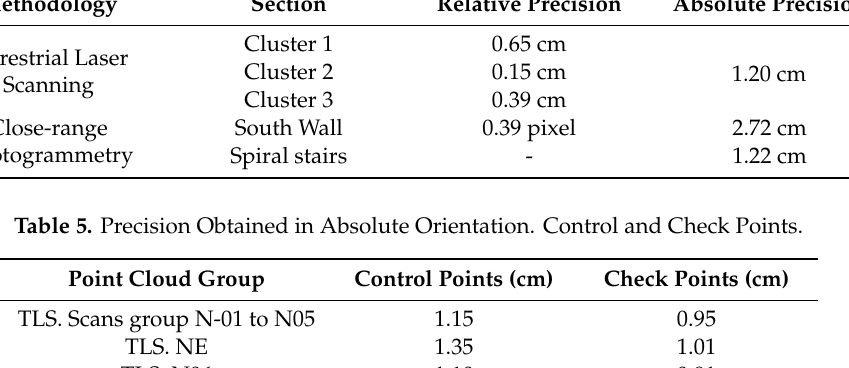
Table 5. Precision Obtained in Absolute Orientation. Control and Check Points.